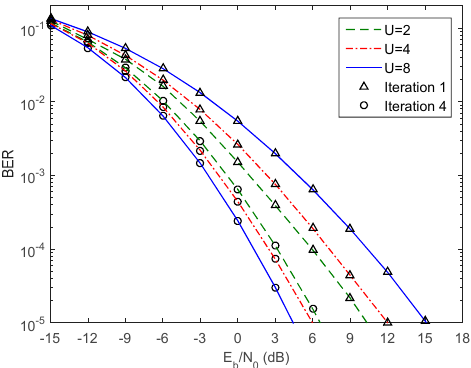
Figure 7. Performance comparison of the proposed iterative hybrid equalizer with N rx = 32, for